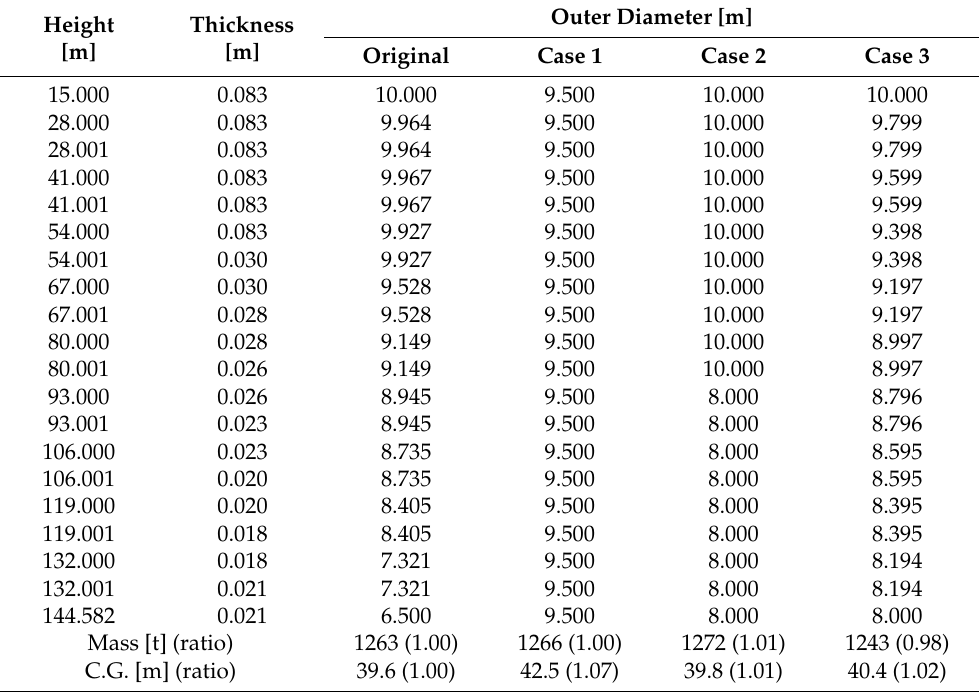
Table 8. Tower dimensions as function of height for four cases.